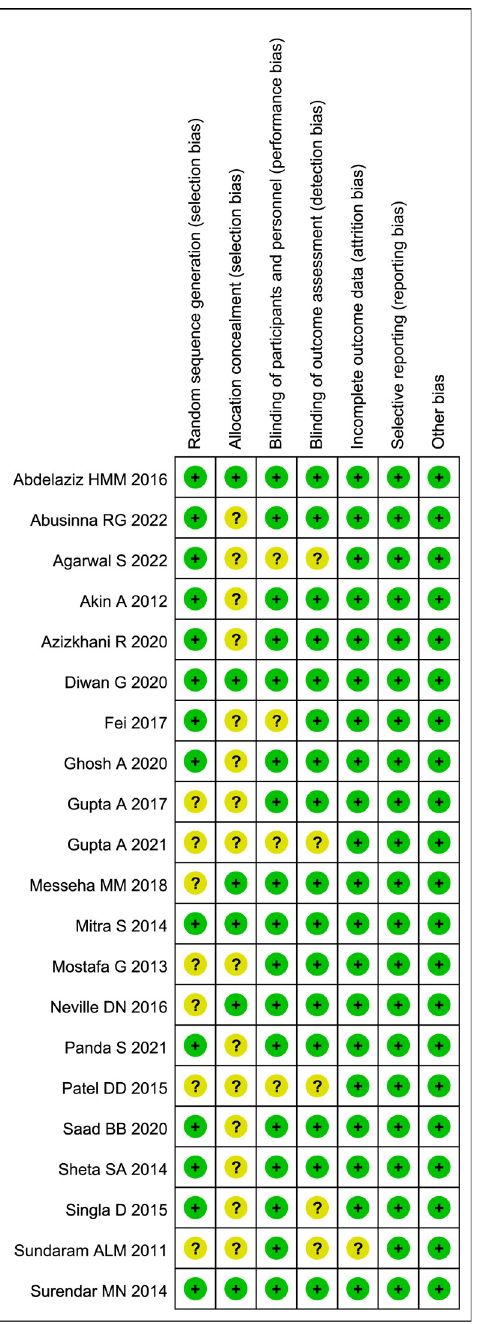
Fig 2. Risk of bias assessment of included studies. Green + dot, low risk of bias; yellow? dot, unclear risk of bias; red —dot, high risk of bias. Number of patients with satisfactory induction or mask acceptance. The results of Mitra S et al . [14] study indicated that patients in clonidine group had significantly better mask acceptance compared to midazolam group (100% vs 80%, P = 0.024). And a total of 500 children in seven studies paid attention on comparison between midazolam and